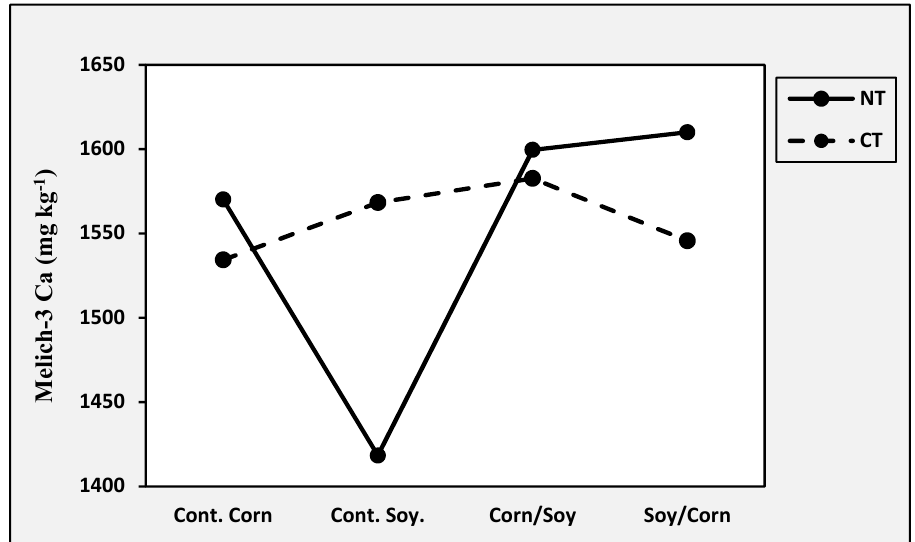
Figure 1. Effects of crop rotation x tillage interaction on Melich-3 Ca in 2013. Please note: NT = no- Figure1. E ff ectsofcroprotation × tillageinteractiononMelich-3Cain2013. Pleasenote: NT = no-tillage; tillage; CT = conventional (moldboard) tillage. CT = conventional (moldboard)